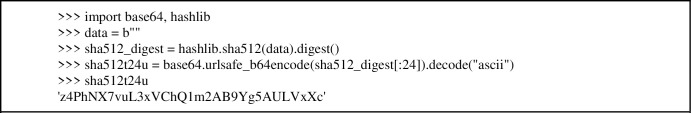
The sha512t24u digest in Python.